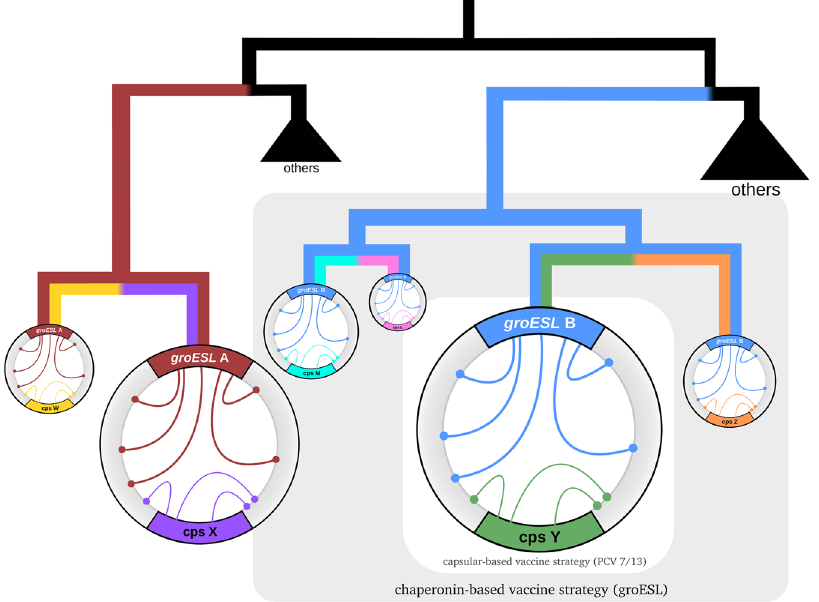
Figure 3. Population structure and vaccination. Conceptual representation of phylogenetic relationships between serotypes and Sequence Clusters (SC), where the former are defined by variation at the cps locus (arbitrarily designated X, W, Y, Z, M, and L, respectively coloured purple, yellow, green, orange, cyan and pink) and the latter are linked to variation in the groESL operon (arbitrarily designated A and B and respectively coloured red and blue). Circles symbolize genotypes, with size relative to their prevalence at the population level. Inner genome arcs represent epistatic links: those with the groESL operon extend across the genome, while links with the cps locus are more local. Within our framework and according to observed patterns 8 , serotypes will be dominantly associated with an SC. Current vaccine strategies (white inner area) that target a selection of capsular serotypes can lead to the expansion of non-vaccine serotypes (VISR 73, 74 ), potentially within the same sequence cluster (VIMS 17 ). Vaccine strategies based on groESL variants (grey area) would target entire lineages instead, including all uncommon serotypes within and thereby preventing their